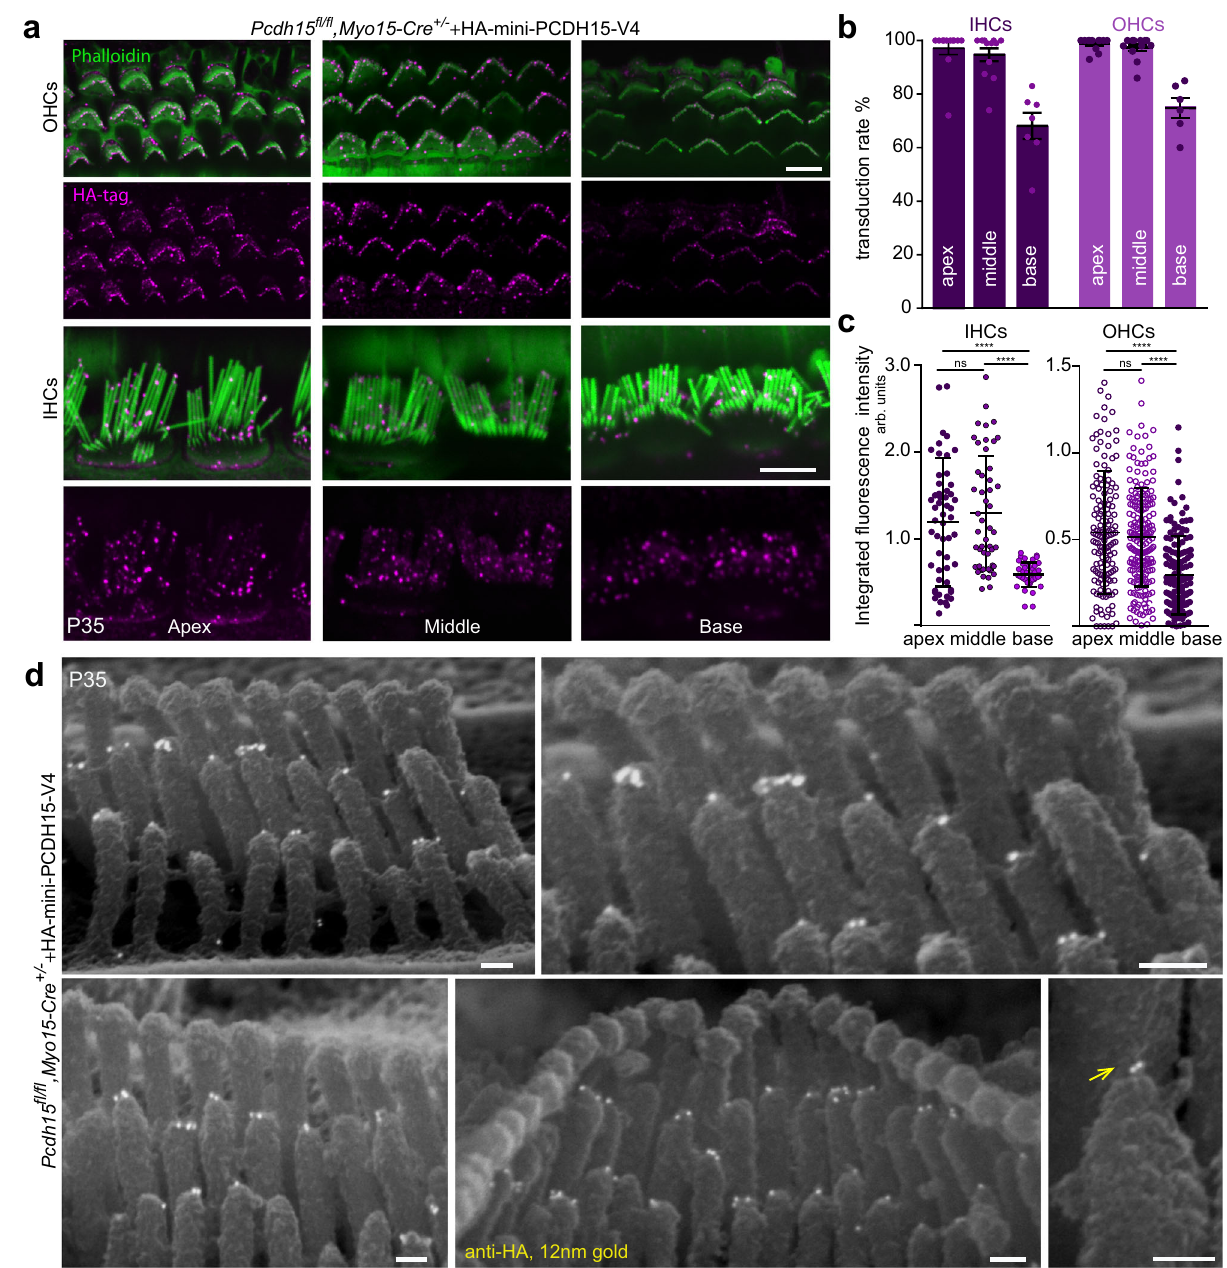
Fig. 6 | Anti-HA staining of HA-tagged mini-PCDH15-V4 demonstrates locali- zation at the lower end of the tip link. a Representative confocal microscopy images at P35 from apical, middle and basal turns of the cochlea show anti-HA staining of HA-mini-PCDH15-V4 (magenta) at the tips of stereocilia (co-stained for phalloidin,green)inknockoutcochleastreatedatP1withAAV-HA-mini-PCDH15-V4. IHCs inner hair cells, OHCs outer hair cells. b Transduction ef fi ciency in IHCs and OHCs at P35 in treated Pcdh15 fl / fl ,Myo15-Cre +/ − conditional knockout mice ( n =12). Dataarepresentedasmeanvalues±SEM. c Quanti fi cationof fl uorescenceintensity of anti-HA labeling in IHCs and OHCs from apical, middle and basal turns of the cochleas in mice treated with AAV-HA-mini-PCDH15-V4. Symbols represent inte- grated fl uorescence intensity in arbitrary units(arb. units) in individualcells(apex: